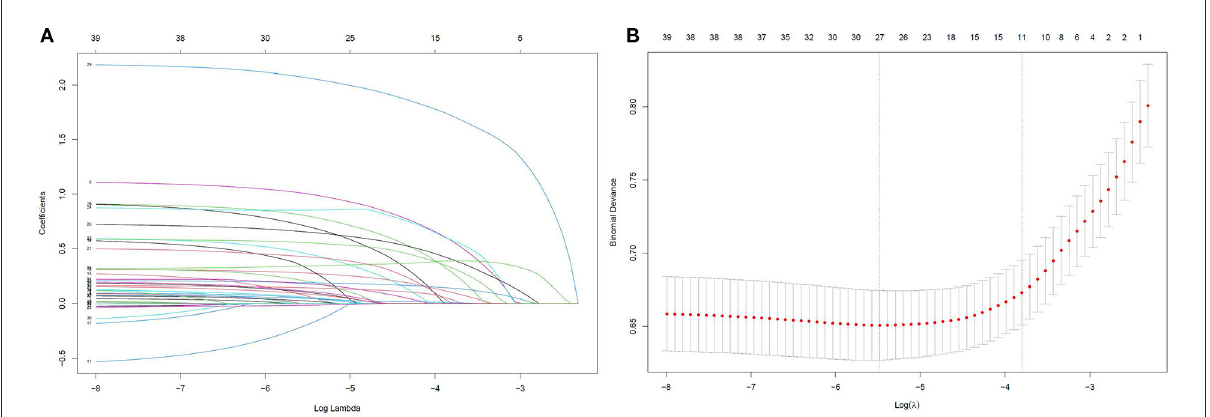
FIGURE2 LASSO regression was used to select the potential risk factors. (A) LASSO coefficient curves for the 40 clinical variables; (B) Binomial Deviance of the LASSO model with different λ . The optimal value of λ (the vertical dashed line) for 10-fold cross-validation was used to select optimal variables. LASSO, least absolute shrinkage and selection